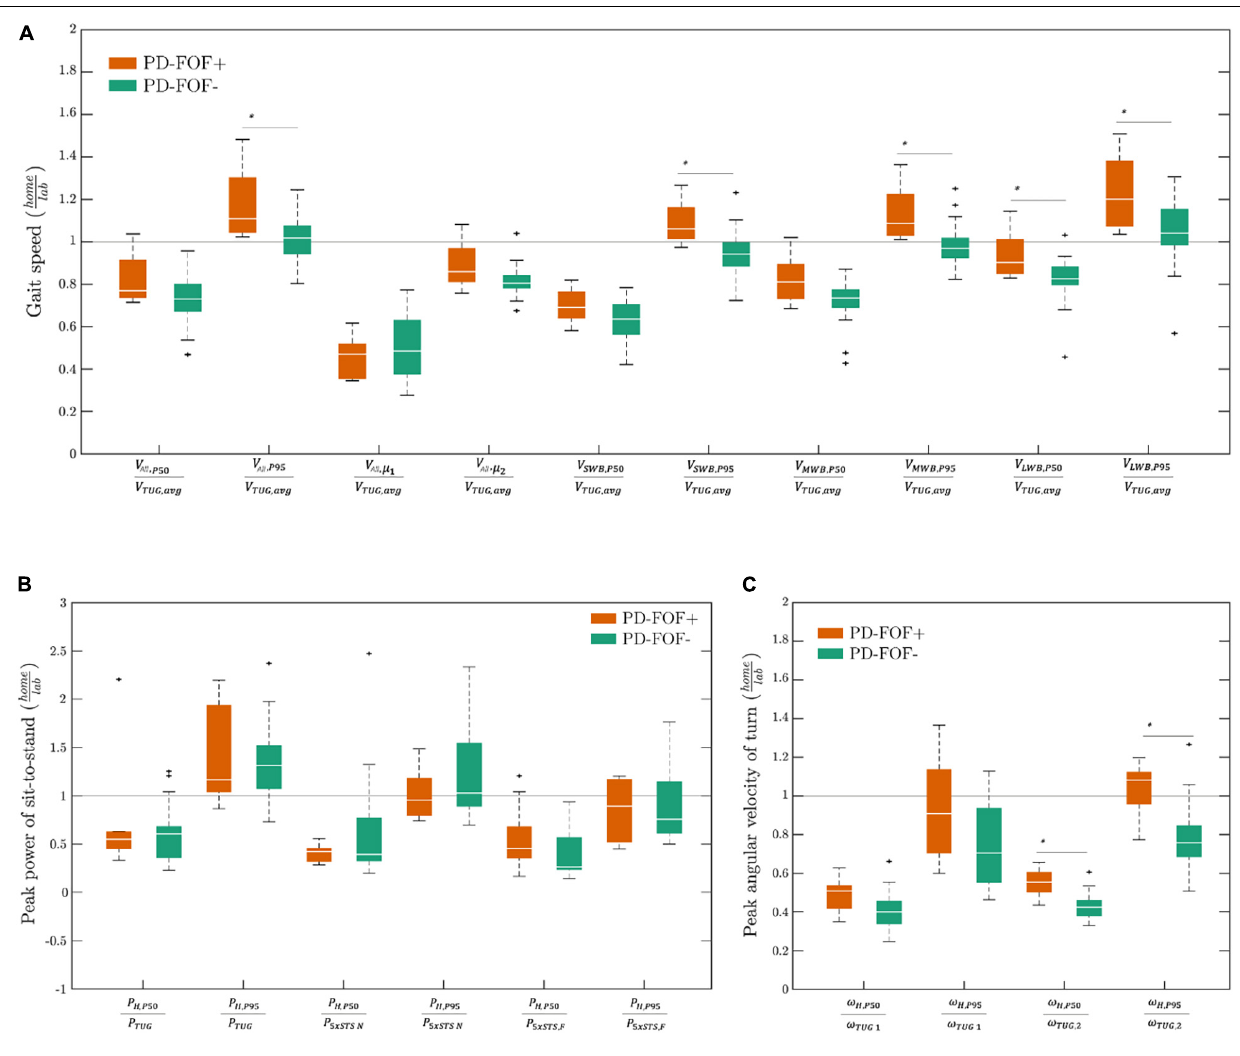
FIGURE 2 | Unitless daily activity divided by lab parameter ratios of (A) gait speed, (B) sit-to-stand peak power, and (C) turning peak angular velocity in PD-FOF+ and PD-FOF − . Differences between the groups were analyzed by the Wilcoxon rank-sum test. Only significant differences were shown on the plots ∗ p <